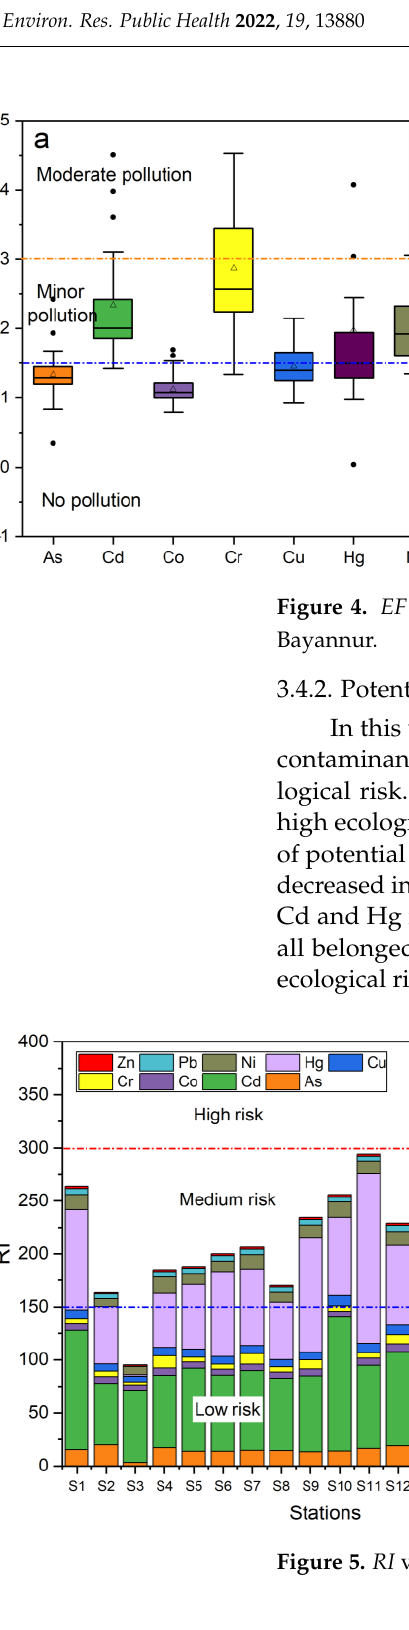
Figure 5. RI values of heavy metals in the 35 surface soils from Hetao Plain in Bayannur.